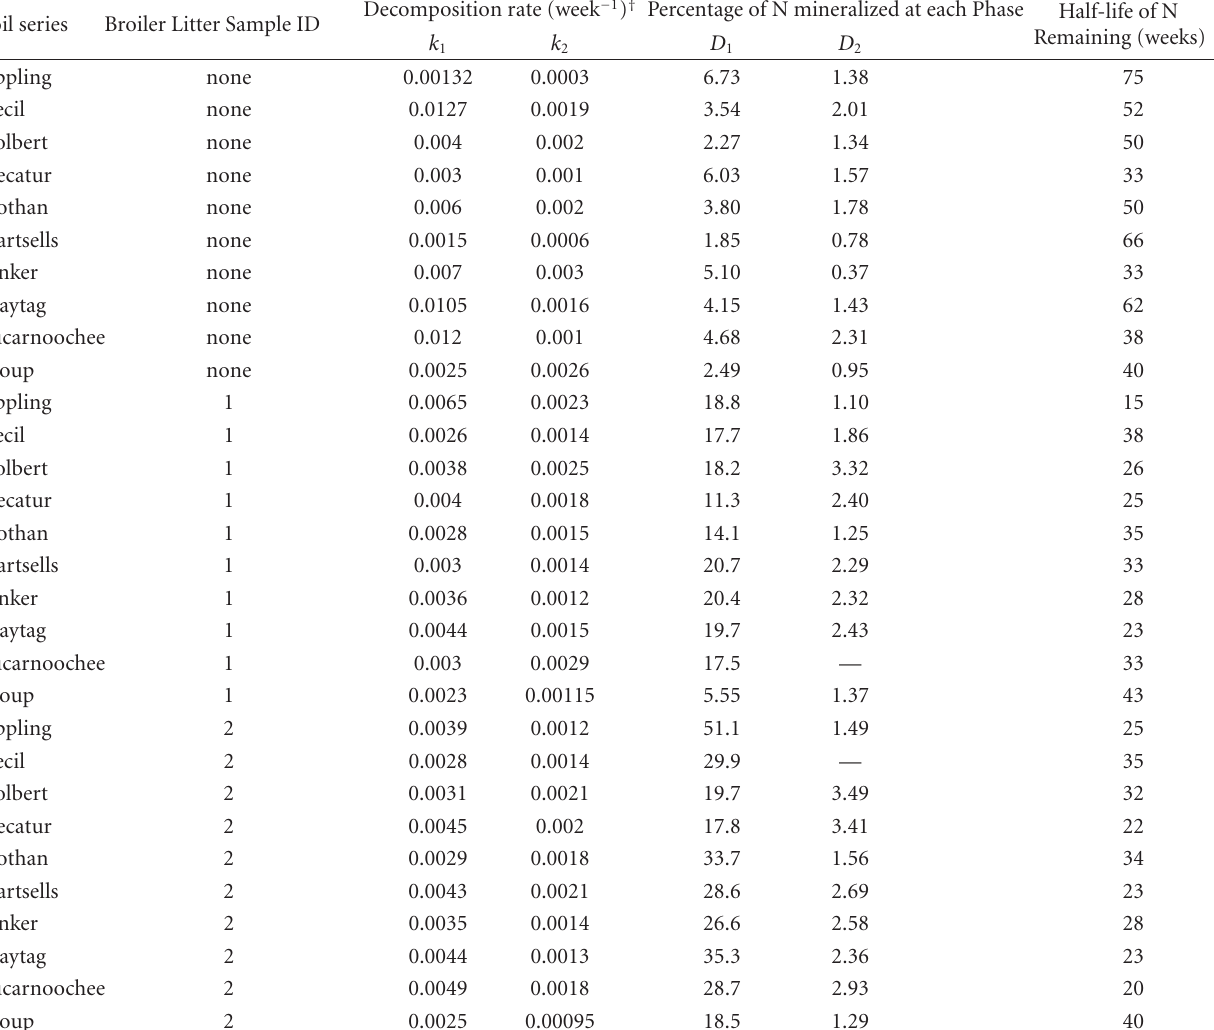
Table 6: First-order rate constants for decomposition of organic N in soil alone and broiler litter-amended soils. Soil